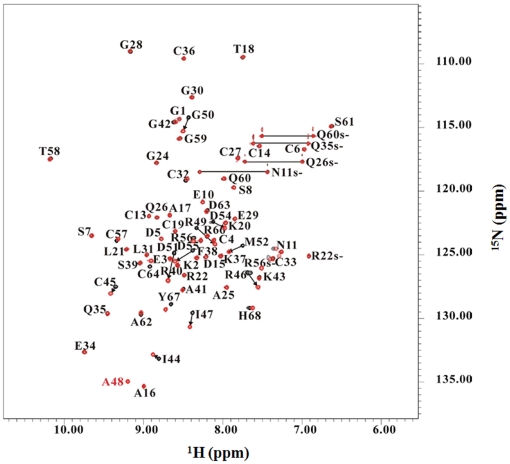
2D 1H-15N HSQC spectra of Rho (black) and its P48A mutant (red) at pH 6.0.Correlation peaks are labelled according to residue type and sequence number. The peaks connected by lines correspond to Gln and Asn side chain NH2 groups. The peaks denoted by the suffix “s” (e.g., Q60s-, N11s-) are the side-chain resonances of Asn, Gln, and Arg.